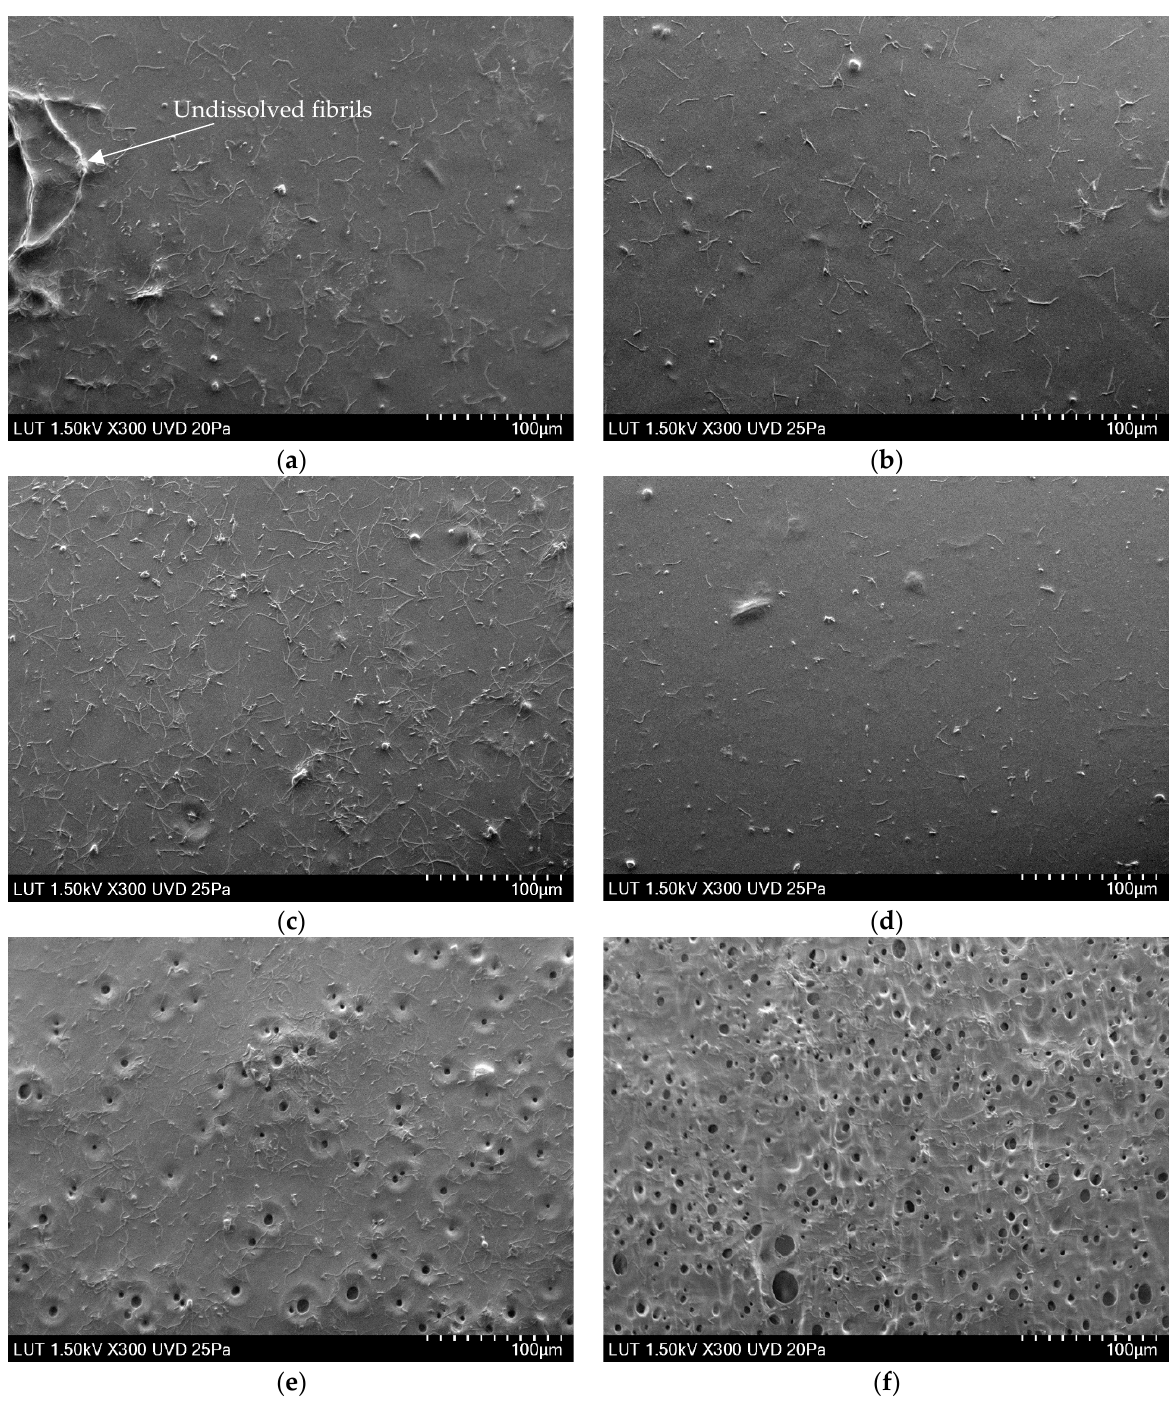
Figure 3. SEM images of membrane top surfaces taken via scanning electron microscope (Hitachi SU 3500, Japan) at an acceleration voltage of 1.5 kV in high vacuum conditions: ( a ) 0 wt.% LiCl, ( b ) 0.1 wt.% LiCl, ( c ) 0.3 wt.% LiCl, ( d ) 0.4 wt.% LiCl, ( e ) 0.5 wt.% LiCl, ( f ) 2 wt.% LiCl.